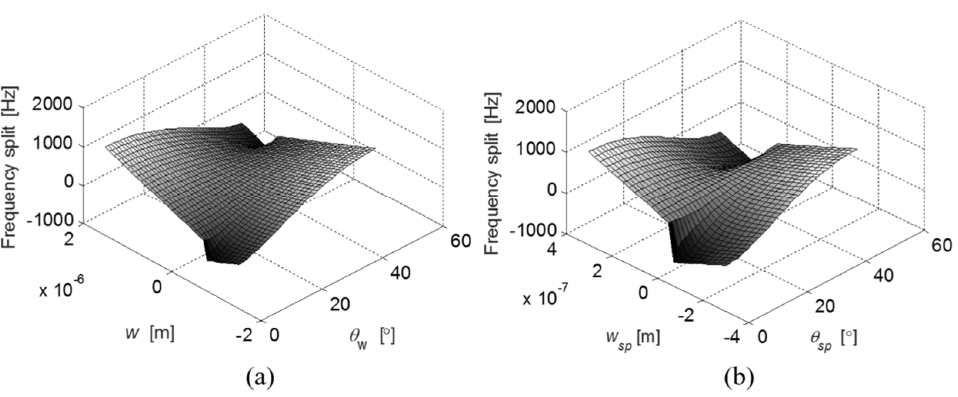
Figure 3. The influence of the width and orientation of the ring ( a ) and the supporting beams ( b ) on the frequency the frequency split.